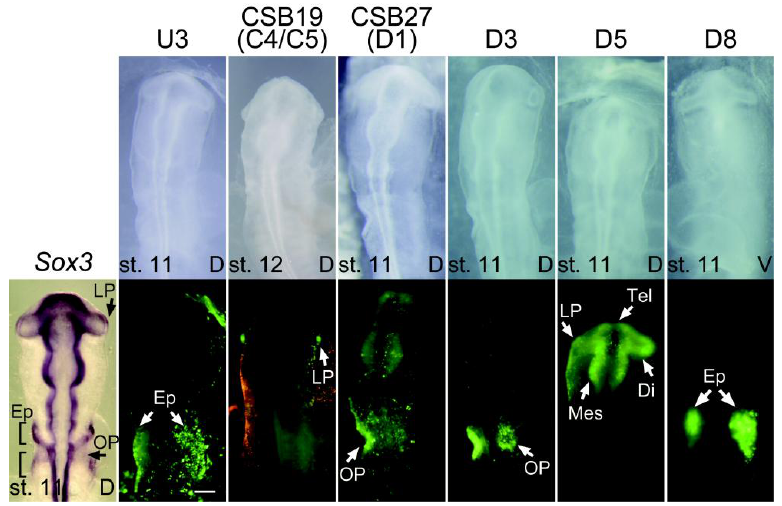
Figure 3. Enhancer activities in placode derivatives of the Sox3 -flanking sequences or CSBs in electroporated chicken embryos at st. 11-12, as indicated by the EGFP expression, in comparison with Sox3 in situ hybridization (left). Top: Bright-field images with indication of developmental stages. V, ventral view; D, dorsal view. Bottom: EGFP fluorescence images of the same field. The bars indicate 200 (cid:80) m. Di, diencephalon; Ep, epibranchial placode; LP, lens placode; Mes, mesencephalon; OP, otic placode; Rho, rhombencephalon; Tel,